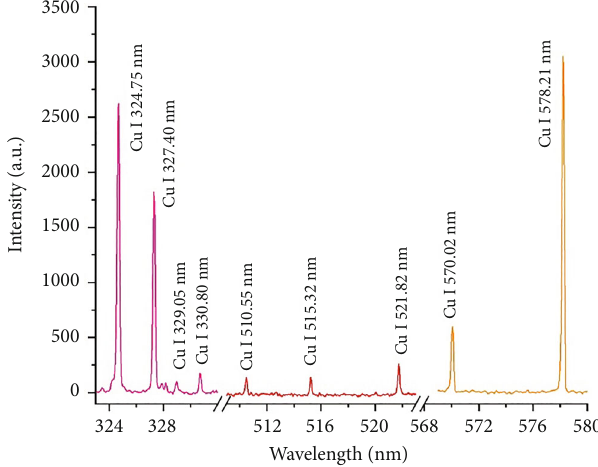
Figure 2: Graph showing the plasma spectra for a Cu plate at H = 149 mm ( f = 150 mm, pulse energy is 20 mJ).